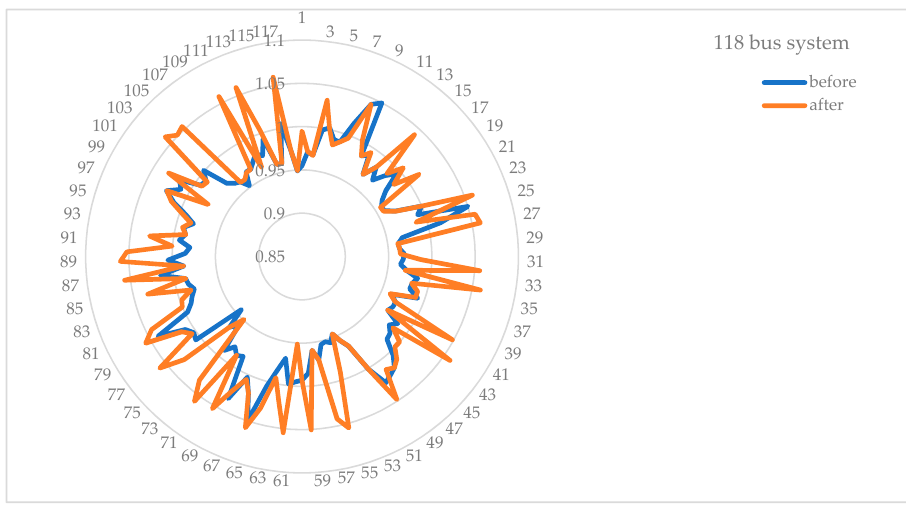
Figure 14. Bus voltages of 118 bus system before and after ORPD.